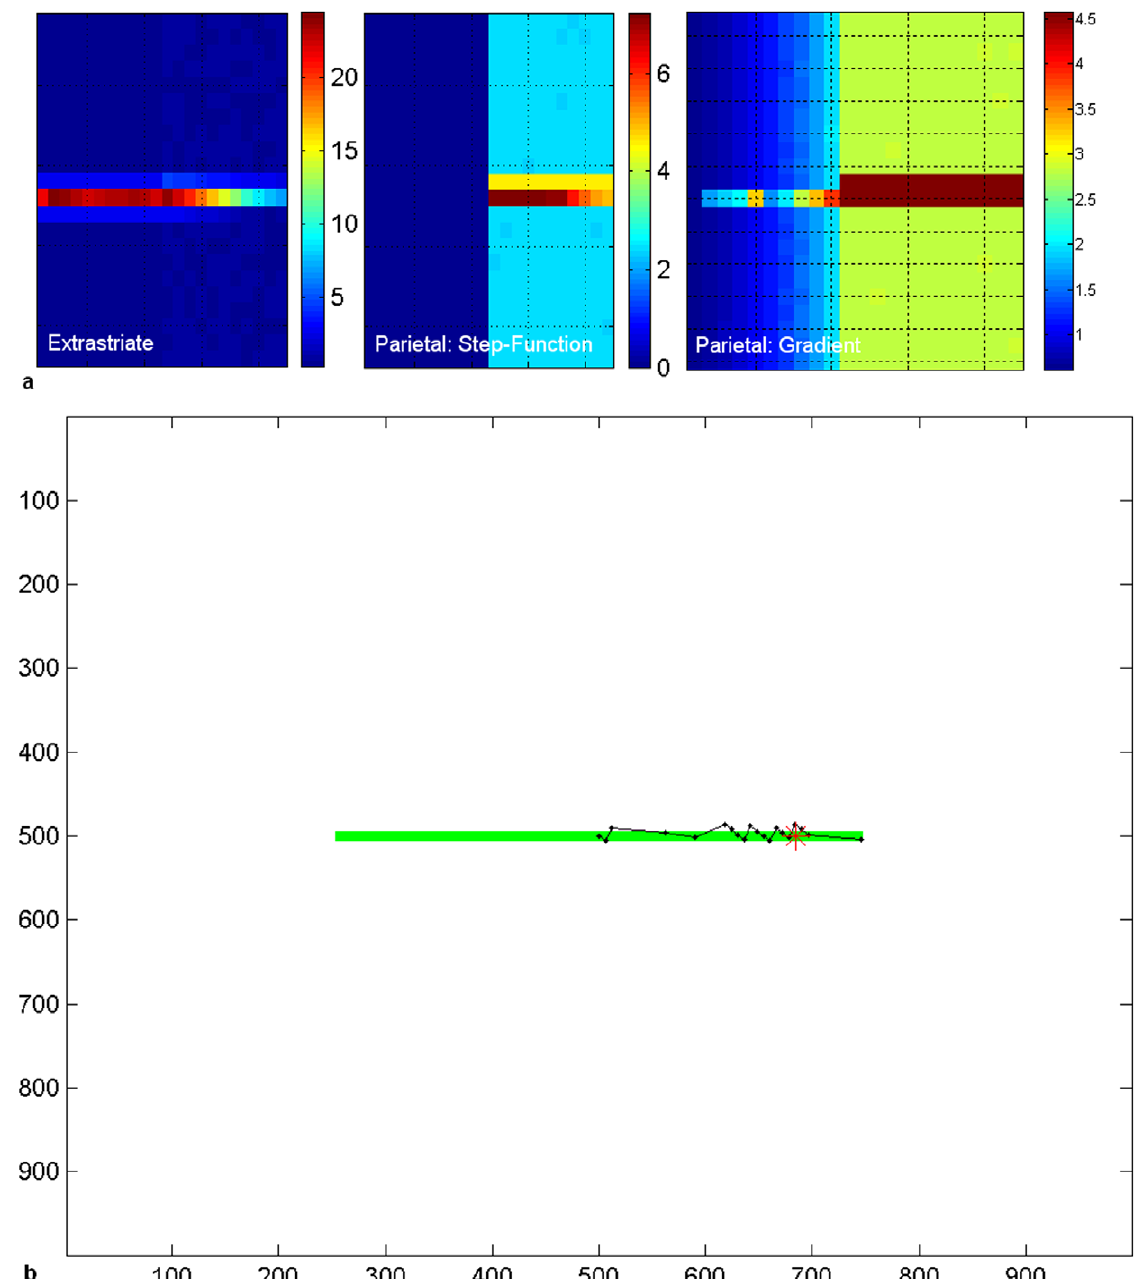
Figure 8. Failed Perceptual Completion in hemineglect with extrastriate lateral connections. a. Cortical activity at 300 ms post-fixation is shown in the extrastriate (left panel) and parietal (middle panel) modules when the parietal module has a step-function lesion. Activity for the entire line is present in the extrastriate cortex and the contralesional part of the line is reinforced by compensation through lateral connections. However, this increased extrastriate activity fails to activate a parietal representation of the contralesional line and, hence, this is neglected. If the parietal module is lesioned in a gradient fashion instead (right panel), the increased extrastriate activity does result in some activity in the damaged parietal area but this is insufficient to win the competition for attention. Level of activity is given by the coloured bar. b. Scanpath with parietal lesion (step- function lesion) and extrastriate lateral connections. The bisection point, which is offset into the ipsilesional half of the line (position 685:16.8 u offset, or an ipsilesional error of 37.4% of line length), is shown as a red asterisk. In this simulation the bisection bias weight was 5. Axes refer to pixel position in the scene. doi:10.1371/journal.pone.0054919.g008 central location, offset slightly contralesionally from the line end of the line. Strengthening the line bisection task bias causes midpoint, which will later become the bisection point. Hence, the more fixations to be clustered around the central bisection point but with most fixations still being placed at the line end. This ipsilesional segment of the line is inspected less. When the line bisection task bias is weak most fixations are located at the blind replicates very well the line bisection scanning behaviour observed